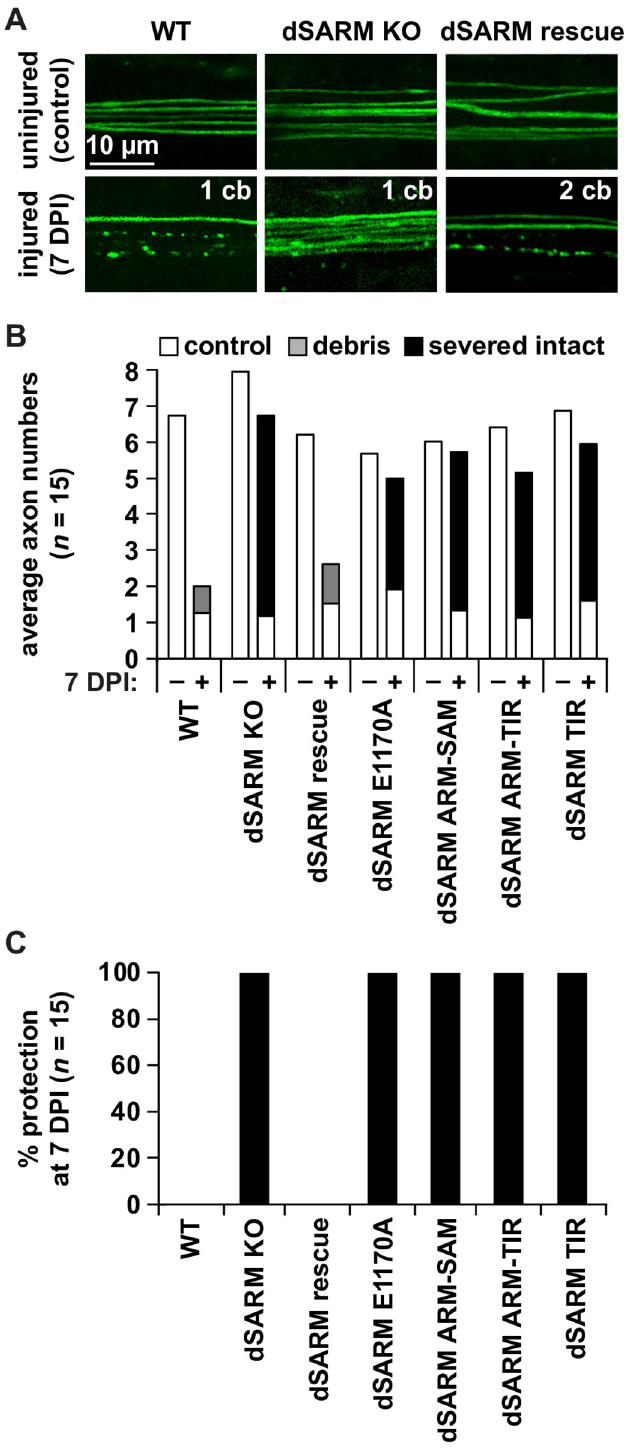
Fig 5. Full length dSARM is needed to trigger axon degeneration. (A) Representative pictures of control and 7 DPI axons of WT, dSARM KO and dSARM rescue. (B) Quantification of average axonal scores of uninjured control, debris, and severed intact axons (white, gray, and black, respectively). (C) Percentage of preserved severed axons at 7 DPI. N = 15 animals for each genotype.